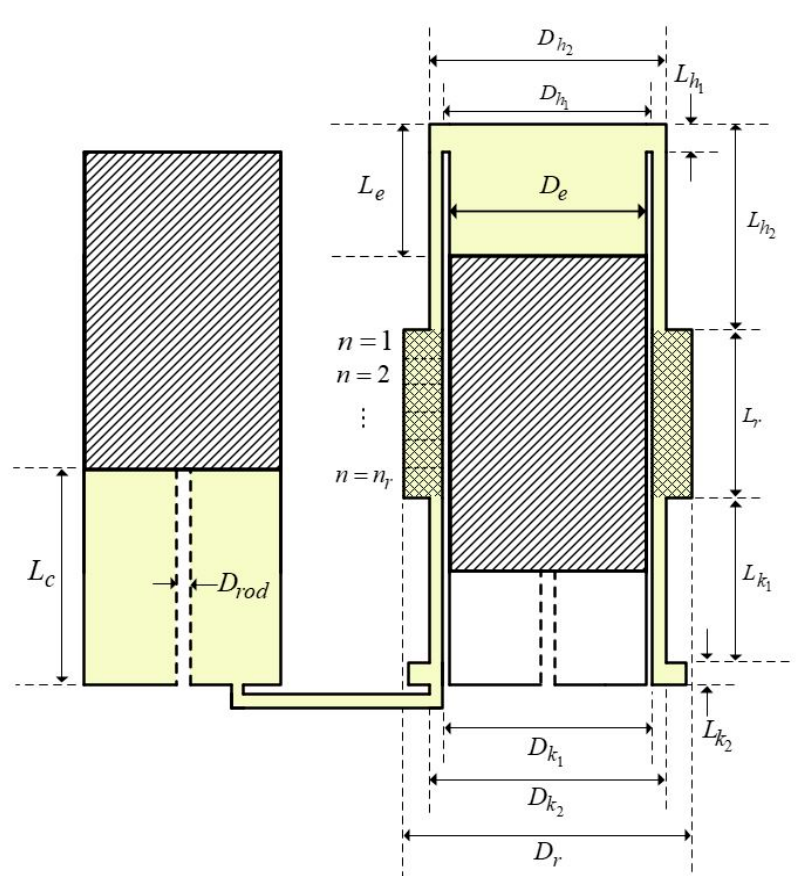
Figure 4. Dimension variables of working zone.